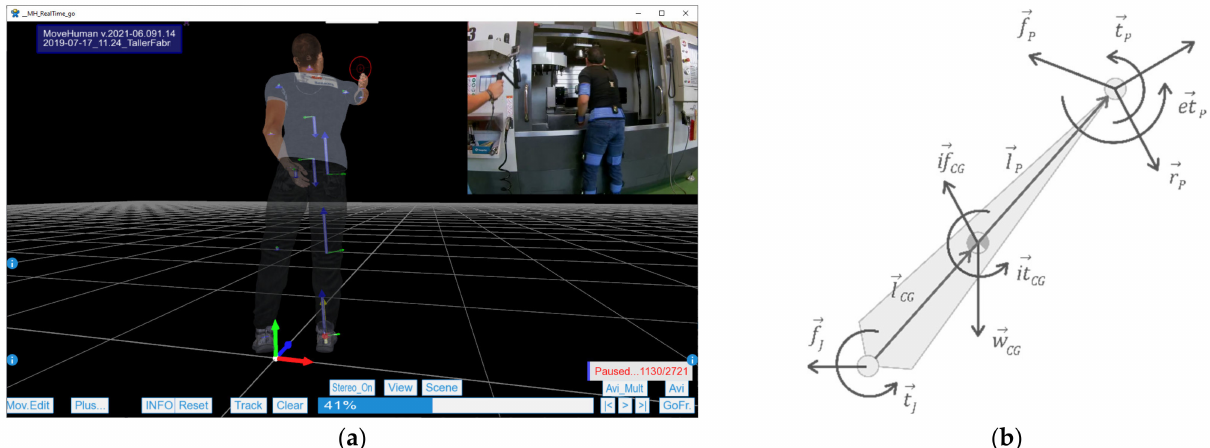
Figure 4. Kinetics calculation. ( a ) Result of the kinetic calculation marking the support situations (red points), the forces (blue arrows), and torques (green arrows) on the joints. ( b ) Segment isolation to calculate force and torque vectors supported by a specific